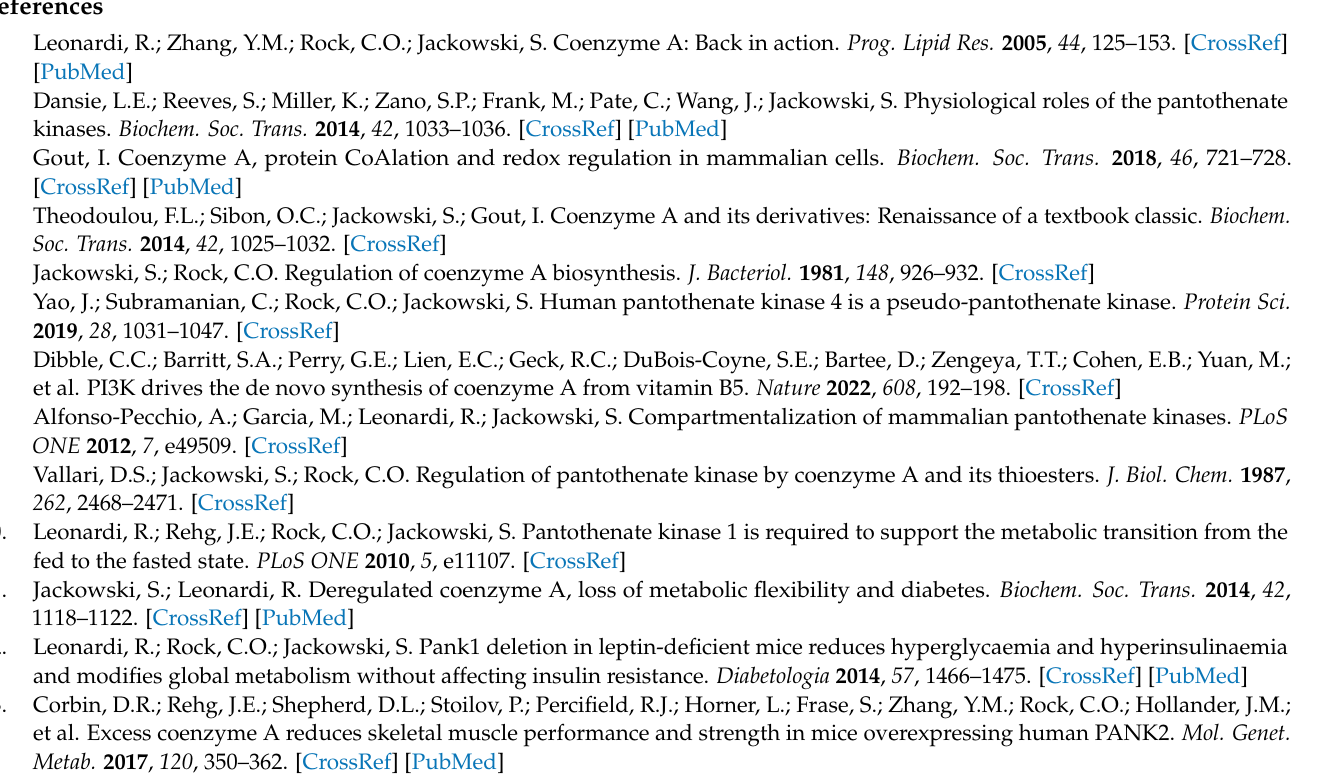
blots shown in Figure 1; Figure S2: PANK1, PANK2 and PANK3 locus identifying 3 different gRNAs that were used to knock the genes out by CRISPR/Cas9 technology. Figure S3: Homology of PANK3 protein across species. Figure S4: Size Exclusion Chromatography elution chromatogram confirms PANK3 protein elutes as homogenous homodimers. Figure S5: Uncropped pictures of the western blots shown in Figure 4. Figure S6: Uncropped pictures of the western blots shown in Figure